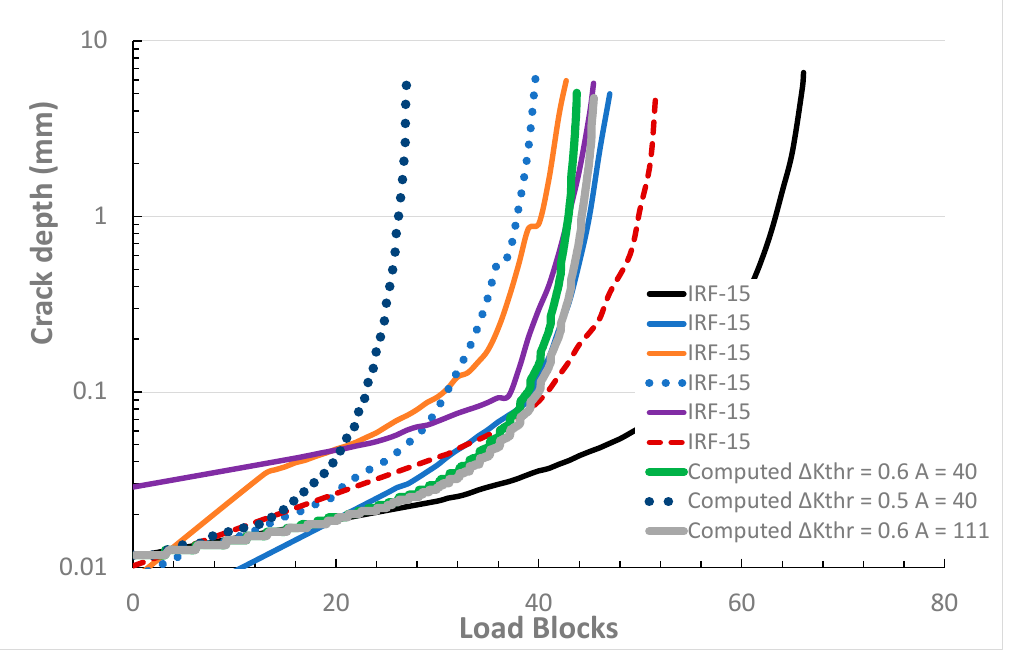
Figure 7. The measured and computed crack depth histories for the helicopter flight load spectrum IRF-E15.